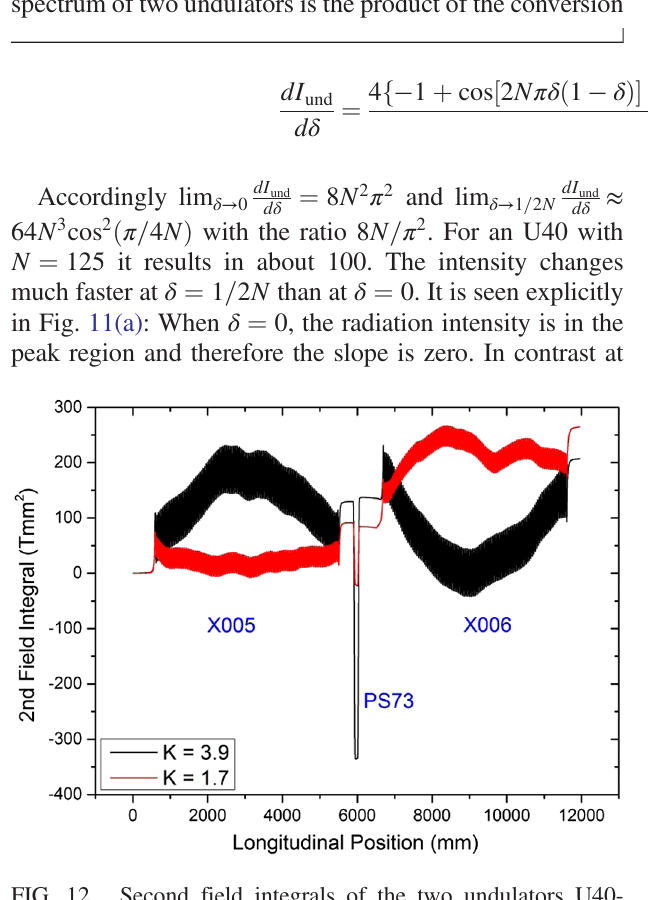
2 π and red curves to the antimatched phase, PS ¼